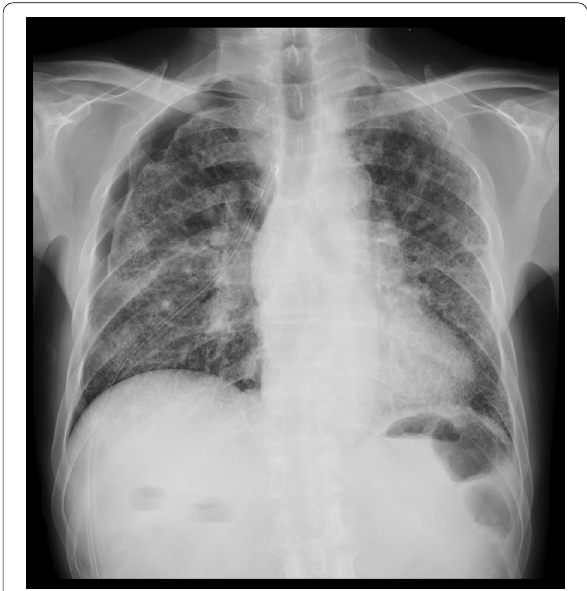
Fig. 2 Preoperative chest X-ray showing incomplete expansion of the right